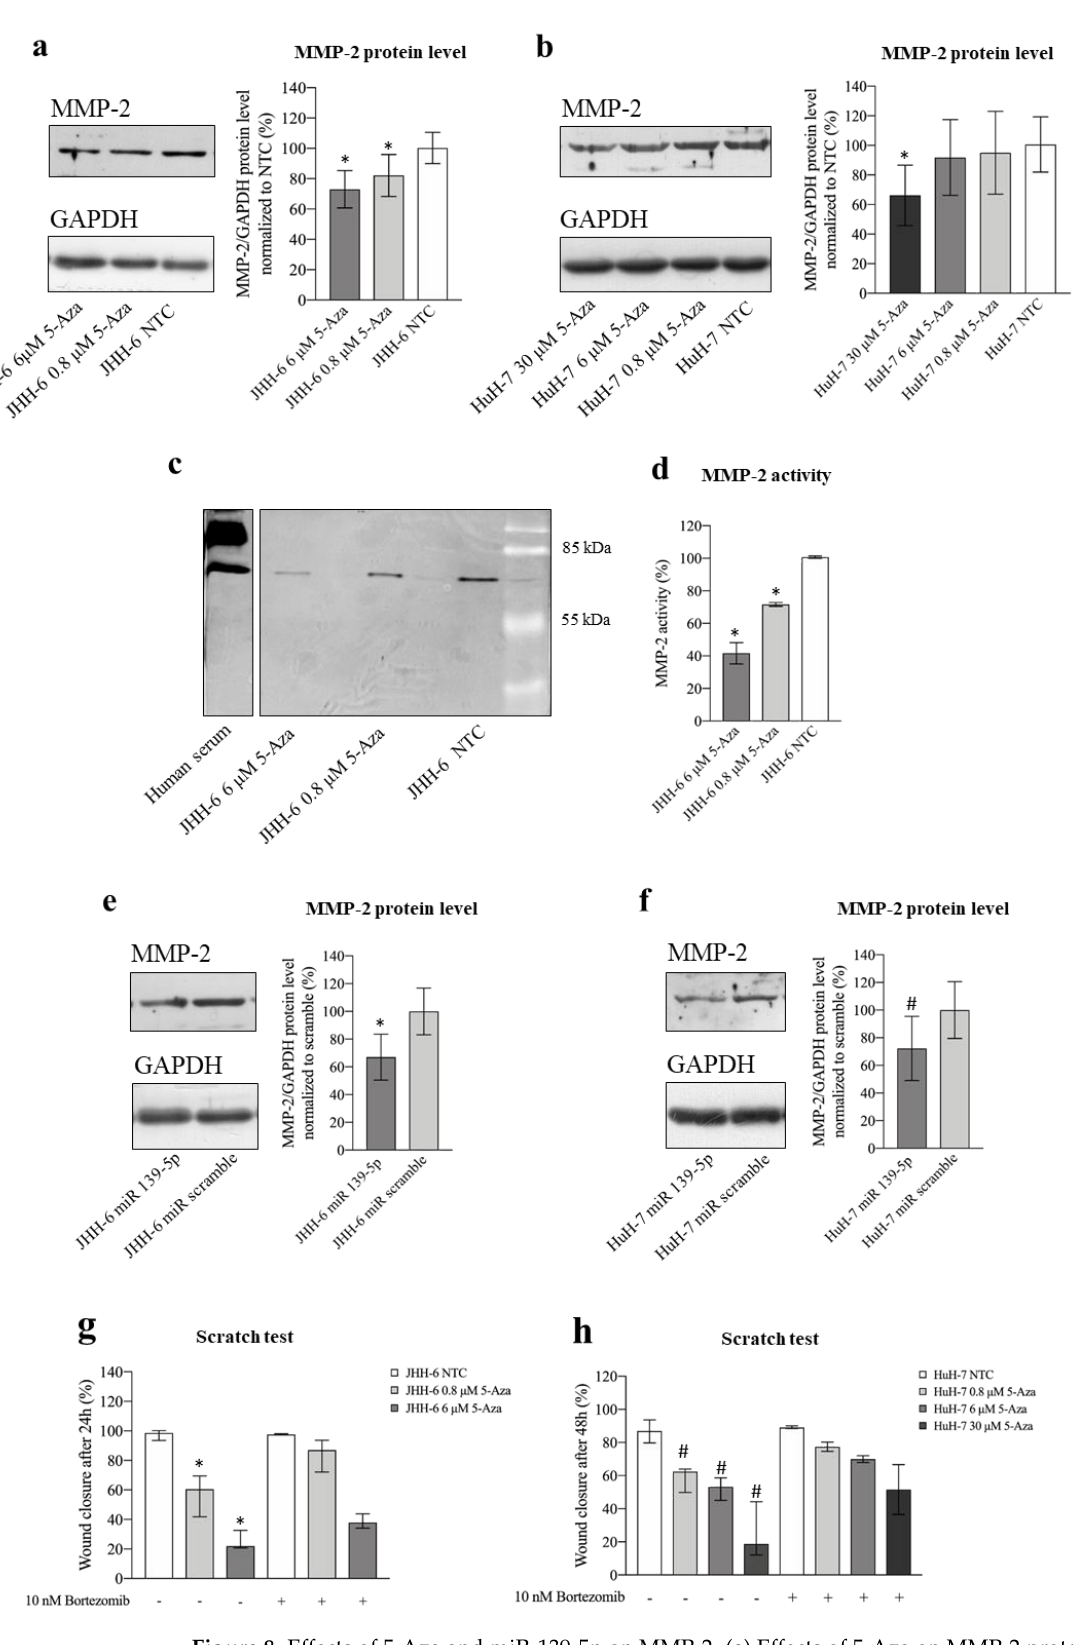
Figure 8. Effects of 5-Aza and miR-139-5p on MMP-2. ( a ) Effects of 5-Aza on MMP-2 protein level in JHH-6. Left, representative Western blot (GAPDH was introduced for normalization); right,